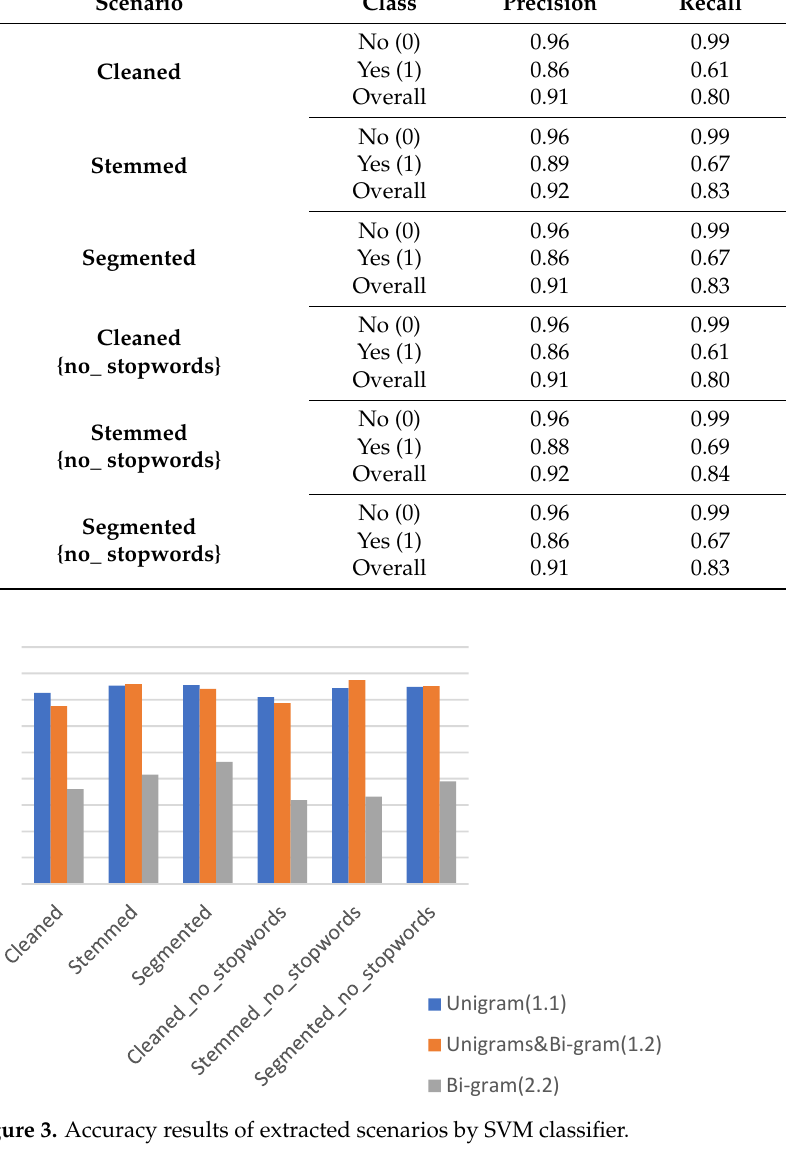
Figure 4. Performance evaluation of SVM with different TF-IDF analyzers. Accuracy can be further improved by using balanced data, where the training sam- ples for positive and negative comments are nearly the same. Comparison of the perfor- mance of similar models shows that the SVM model achieves better performance and a higher resolution with TF-IDF (unigram and bigram) range (1, 2), where Stemmed_no_stopwords scored a total of 95.742% for accuracy. As a result, we noticed that the stemming tool converts all different structures of words into their root forms and this helps the classifier to identify the bullying words and assign them to the correct class. Moreover, the model achieved better results when these stopwords were not taken into account, to reduce obfuscation in Arabic sentences. As a synthesis, the results show that SVM outperforms NB in terms of classification accuracy. In this study, recall that we have classified Arabic cyberbullying tweets using two machine learning techniques: NB and the SVM classifier. Then, we have shown how the SVM classifier provides the best results in predicting cyberbullying comments with